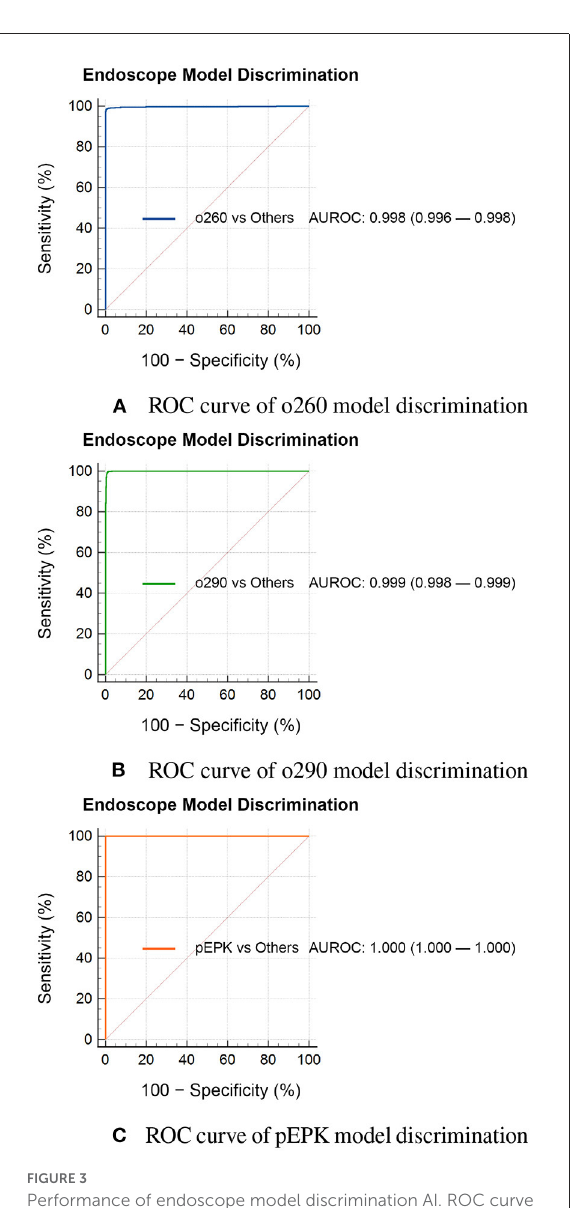
FIGURE3 Performance of endoscope model discrimination AI. ROC curve of (A) o260, (B) o290, and (C) pEPK model discrimination. The AI predicting the endoscope model that captured the images, had errors in determining (A) 93 images in the o260 dataset set were pictured with an Olympus CV-290 and (B) 14 images in the o290 dataset were taken with an Olympus CV-260SL. (C) It successfully determined all the pEPK dataset images captured with PENTAX EPK-i. o260, Olympus CV-260SL; o290, Olympus CV-290; pEPK, PENTAX EPK-i; AUROC, area under the receiver operating characteristic